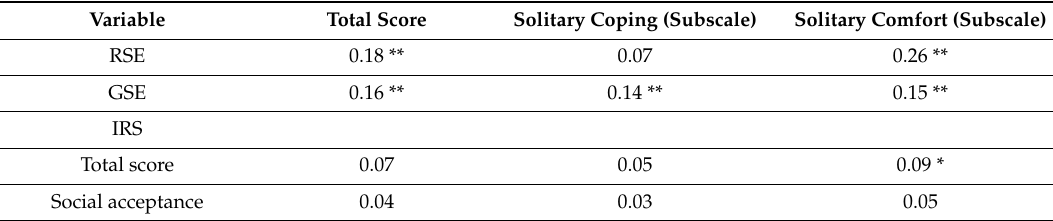
Table 2. Correlation coe ffi cients among the Solitude Capacity Scale, Rosenberg Self-Esteem